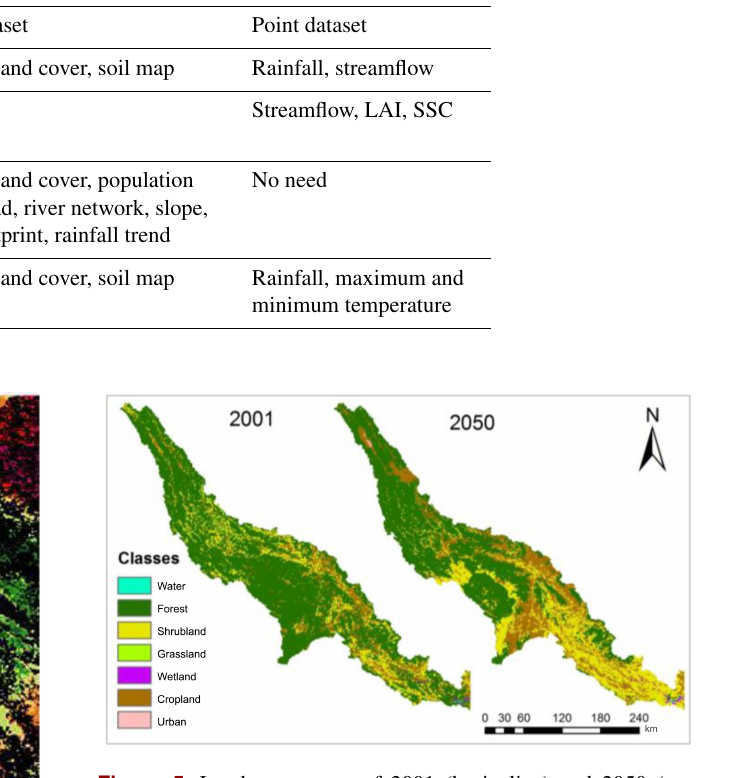
Figure 5. Land cover map of 2001 (basin line) and 2050 (pre-